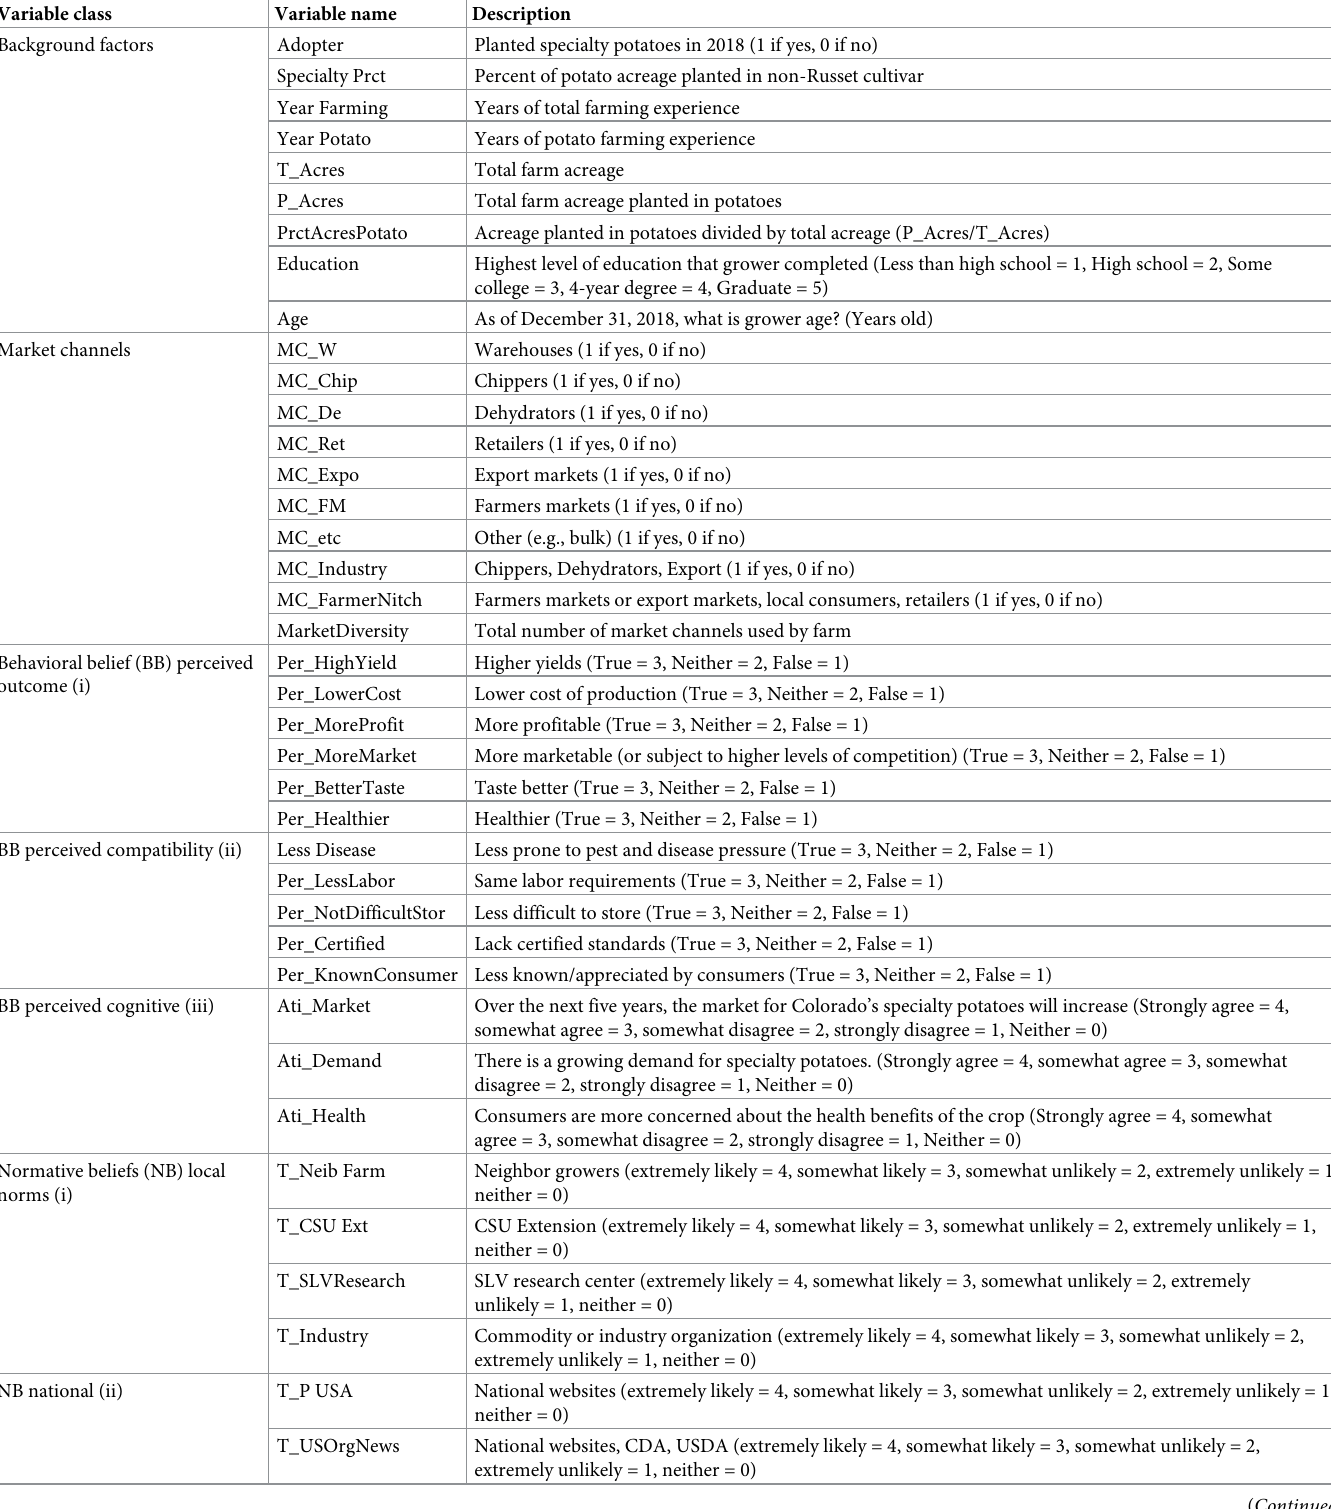
Table 1. Survey translated to descriptions and corresponding independent